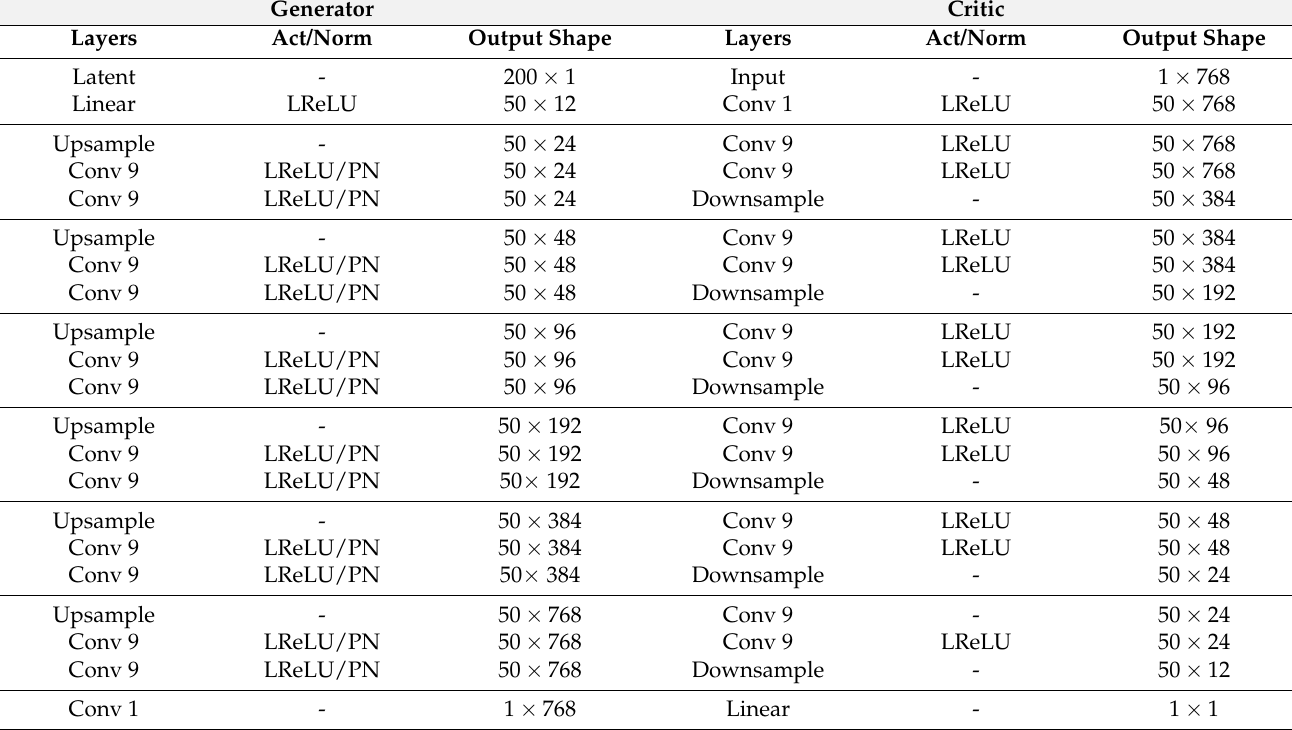
Table 1. Structures of generator and discriminator